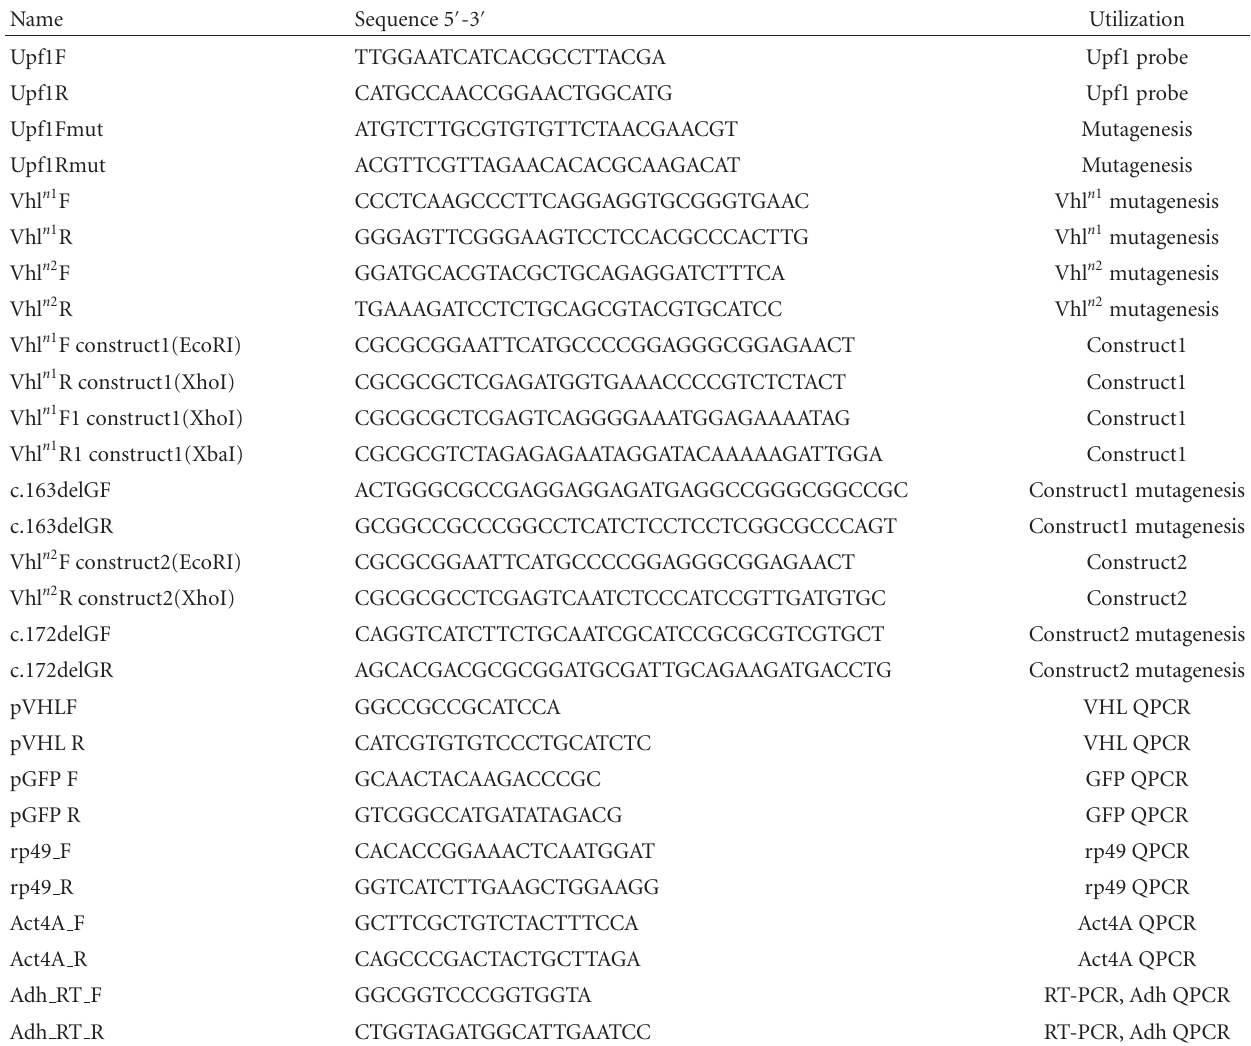
Table 1: Primer’s list used in this